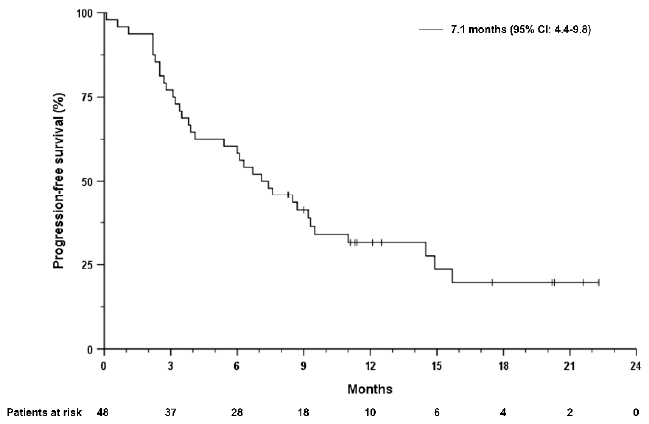
Figure 1. Overall survival of the overall study cohort, independent of the therapy line. Overall survival was defined by the date of treatment start to death from any cause. Tick marks indicate censored data.